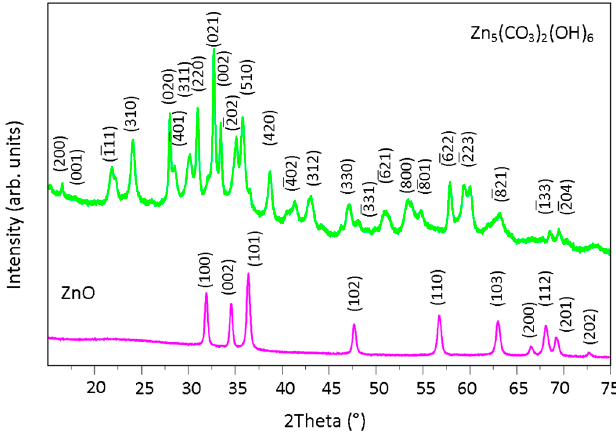
Figure 6. X-ray di ff raction patterns of Zn-Carb (green) and ZnO (violet) Figure 6. X-ray diffraction patterns of Zn-Carb (green) and ZnO (violet) powders.